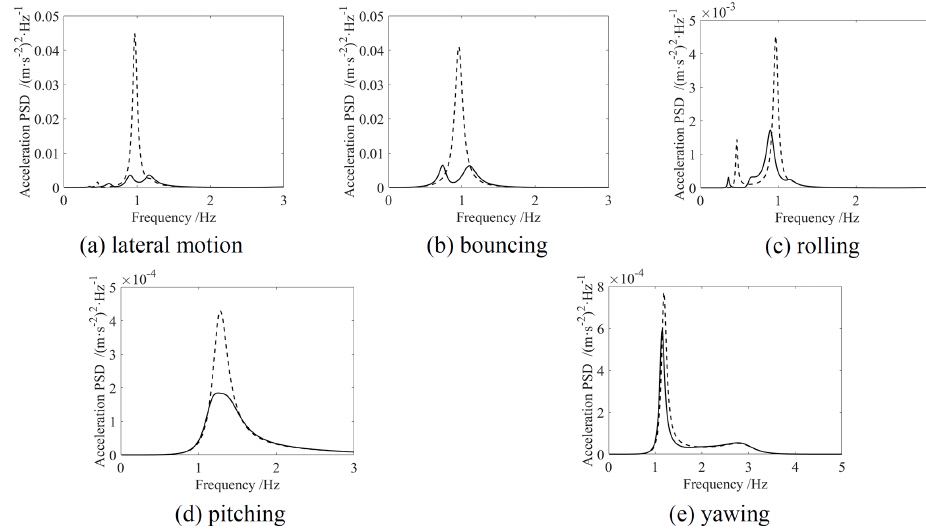
Figure 6. PSD of each DOF of the car body. Dashed line: without MDOF DVA; solid line: with optimized MDOF DVA.